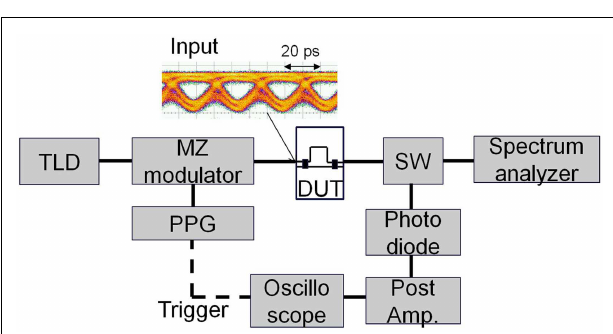
FIGURE 5 | Experimental setup for decoding of 40-Gbit/s DPSK signals